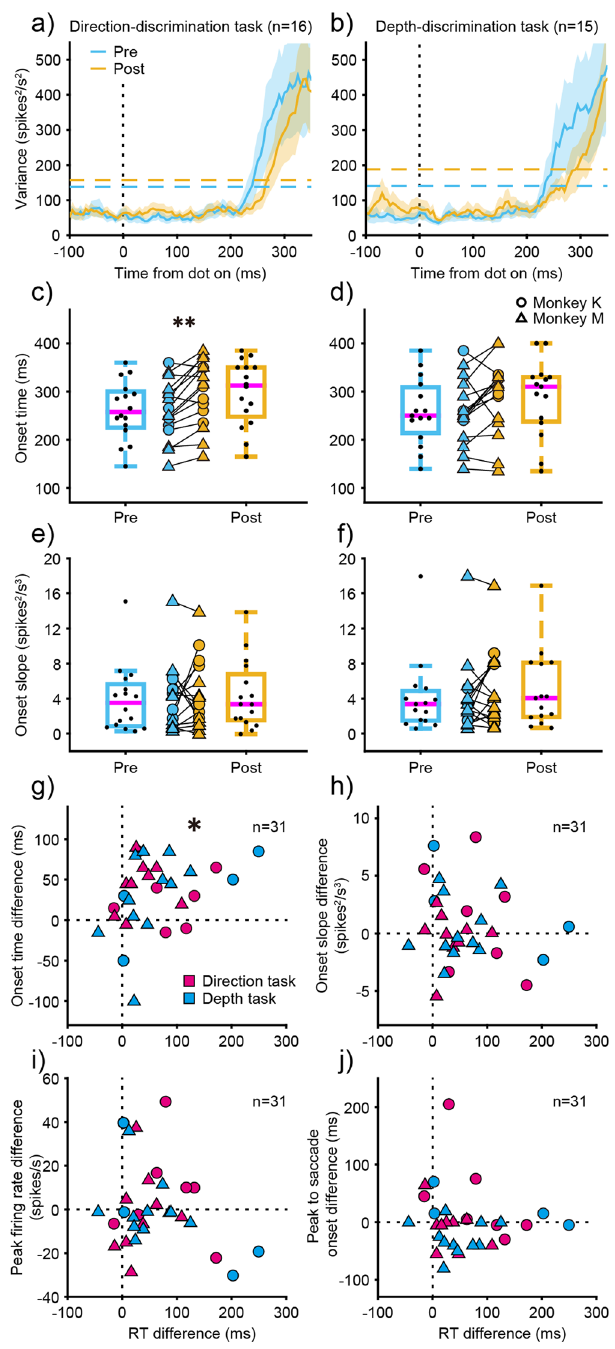
Fig. 5 Effects of ketamine on build-up onset. Build-up onset of LIP neurons before and after ketamine administration for the direction-discrimination task ( a ) and the depth-discrimination task ( b ). Solid lines denote fi ring rate variance among different motion coherences at zero binocular correlation for the direction-discrimination task, and among different binocular correlations at zero motion coherence for the depth-discrimination task aligned to visual stimulus onset. Dashed-horizontal lines denote average threshold corresponding to three standard deviations above the baseline. Blue denotes before administration, and yellow denotes after administration. Shaded area denotes SEM. Build-up onset time ( c , d ) and slope ( e , f ) before and after ketamine administration for the direction- discrimination task ( c , e ) and the depth-discrimination task ( d , f ). Onset time denotes when the variance deviated from threshold corresponding to three standard deviations above the baseline, and onset slope denotes the slope of fi tted line around onset time. Circles and triangles denote each experimental data for monkey K and monkey M, respectively. Asterisks indicate statistically signi fi cant results (Wilcoxon signed-rank test; ** p < 0.01). Boxplot conventions are the same as in Fig. 2. Relationship between RT delay and build-up onset delay ( g ), build-up onset slope difference ( h ), peak fi ring rate difference ( i ) and peak to saccade onset difference ( j ). Magenta denotes data for the direction-discrimination task, and cyan denotes data for the depth-discrimination task. Asterisks indicate statistically signi fi cant correlation (Spearman ’ s; * p <